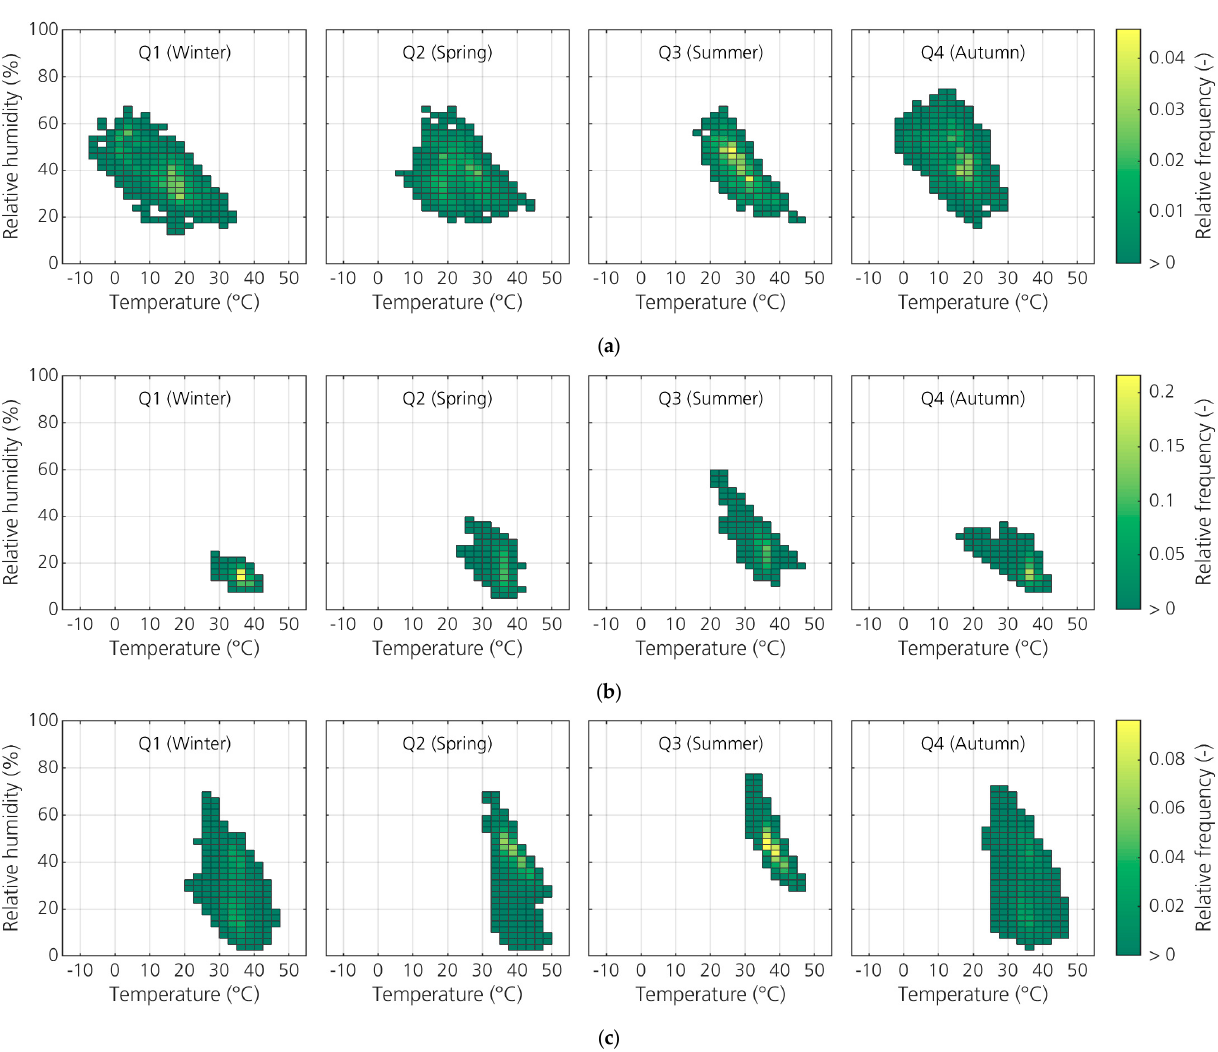
Figure 12. Quarterly distributions of the converter-cabinet internal climatic conditions of wind turbines WT1 ( a ), WT2 ( b ) and WT3 ( c ). Note that the diagrams of Q3 in WT1 and of Q1 in WT2 are based on limited data of only approx. 6 weeks each.